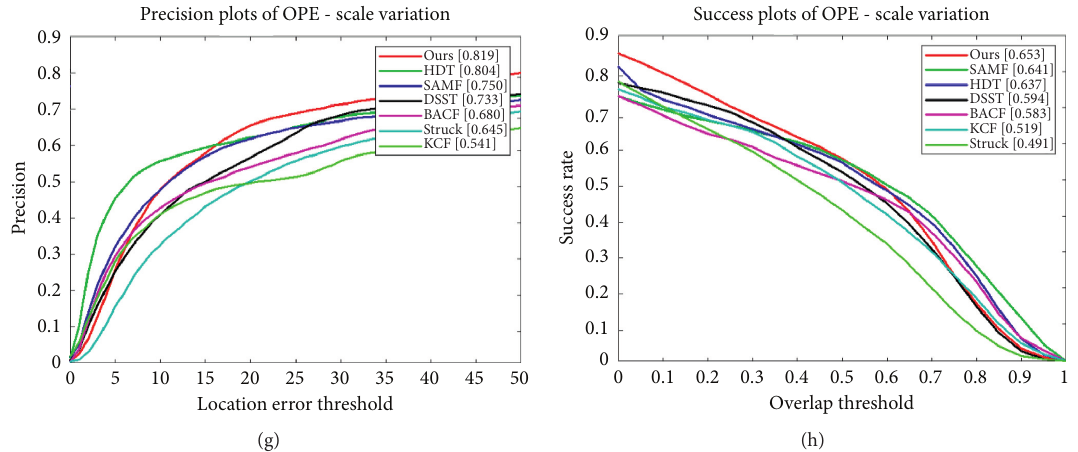
Figure 8: Distance precision and overlap success plots on different attribute scenarios.